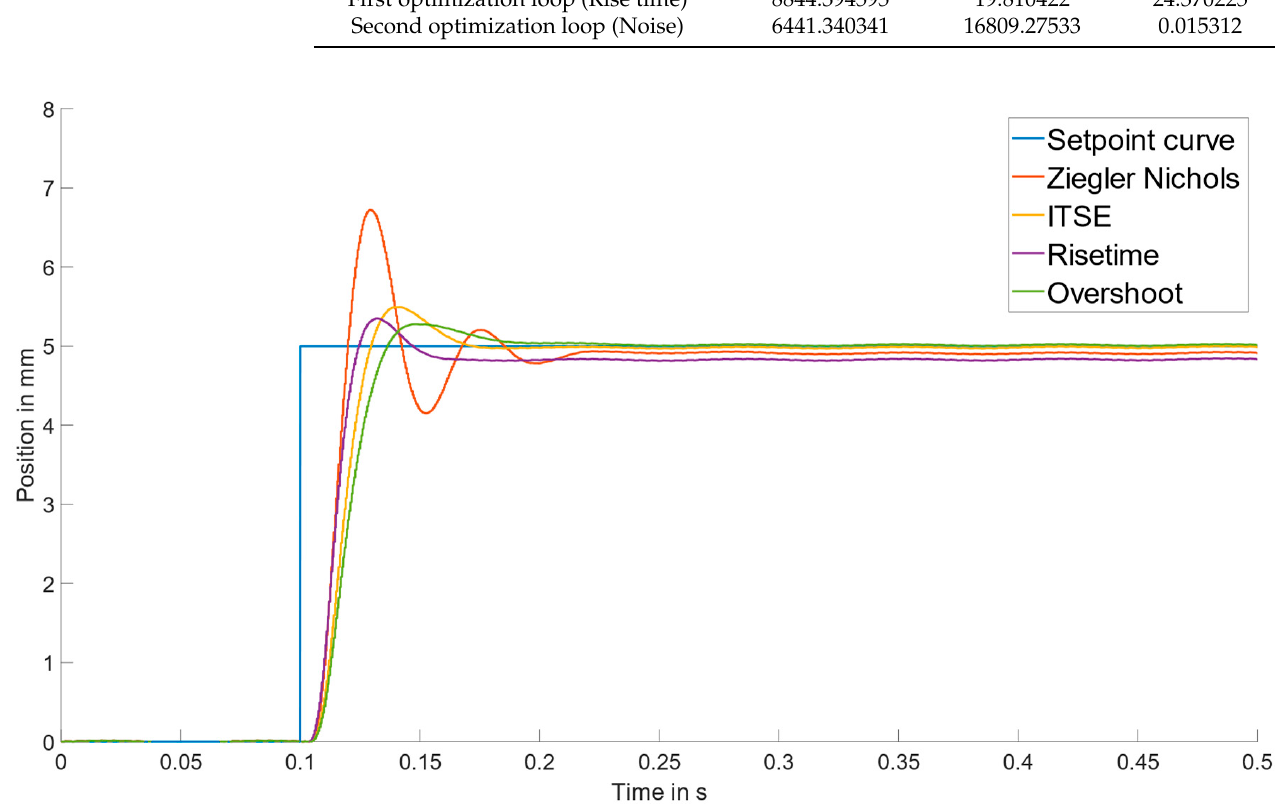
Figure 6. Step responses for the EHA simulation model for the PID parameters presented in Table 4 and the spring load of a spring stiffness of 241.381 N/mm.